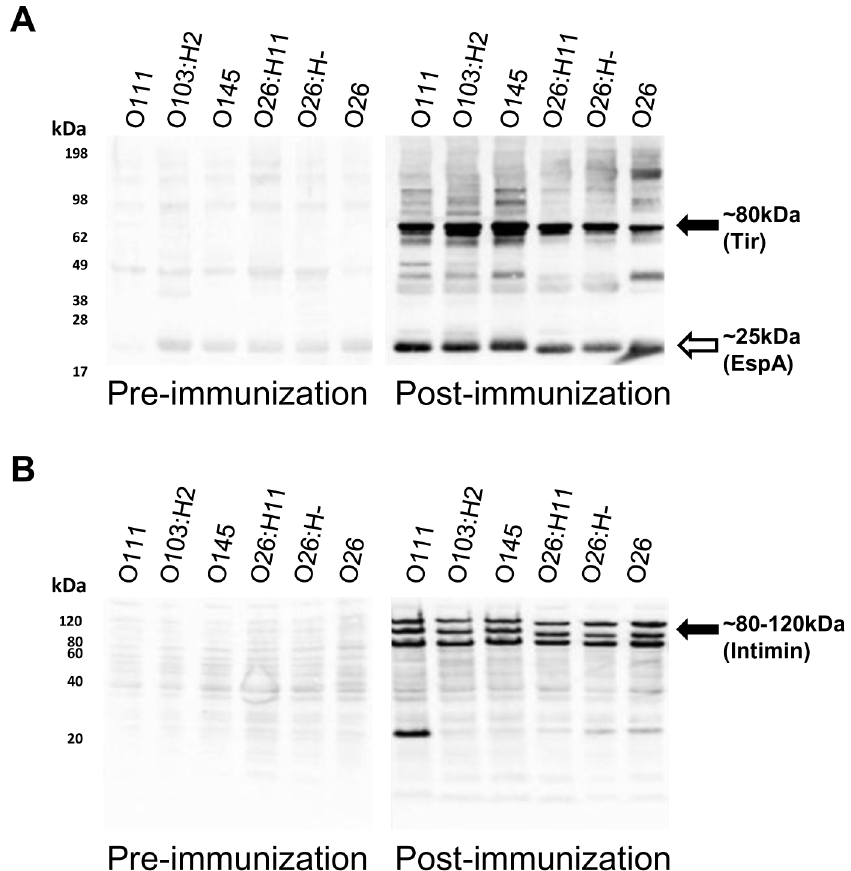
Fig 5. Cross-reactivity of vaccine-induced antibodies with secreted and whole cell antigen preparations from non-O157 EHEC serotypes. Representative western blot of (A) secreted protein preparations and (B) whole cell preparations from EHEC serotypes O111, O103:H2, O145, O26:H11, O26:H- and O26 with serum collected from a calf collected 2 days prior to first immunization (Pre-immunization) and 6 days after the final immunization (Post-immunization) with recombinant EspA, intimin and Tir. Bound IgG1 was visualized by chemiluminescence. The putative identities of EspA, Tir and intimin-reactive bands are indicated in